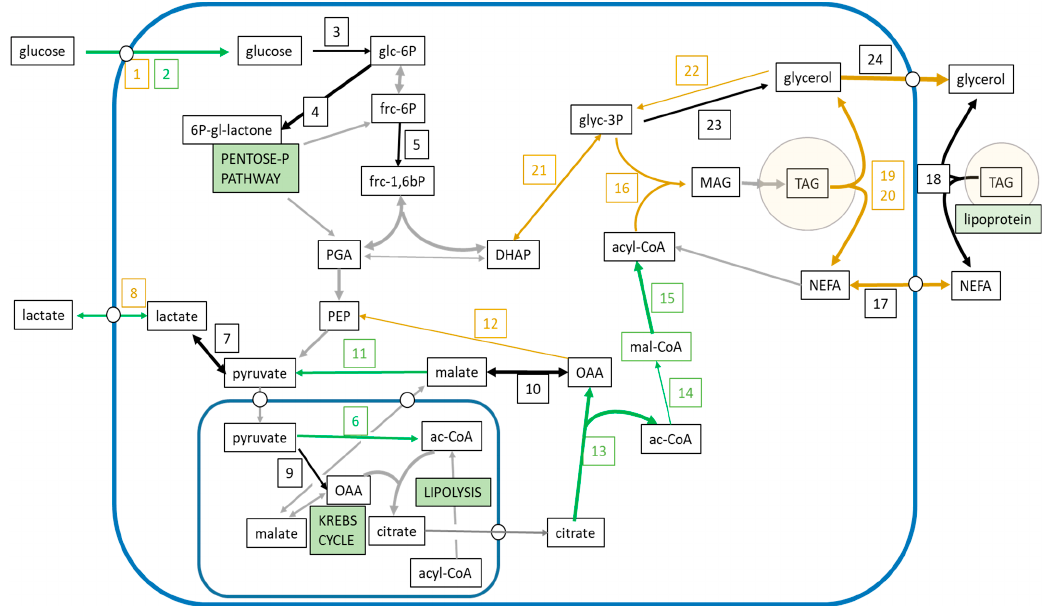
Figure 6. Insulin regulation of the main metabolic pathways in the adipocyte during incubation with glucose. The graph presents the main intermediate metabolites and substrates. Green lines correspond to pathways activated by incubation with insulin, whereas brown lines represent inhibited pathways. The figure incorporates data from label fate, metabolite concentrations, specific radioactivity, and gene expression. The squares with numbers represent the genes whose expression has been measured. 1 — Glut1 (glucose transporter type 1). 2 — Glut4 (glucose transporter type 4). 3 — Hk1 (hexokinase